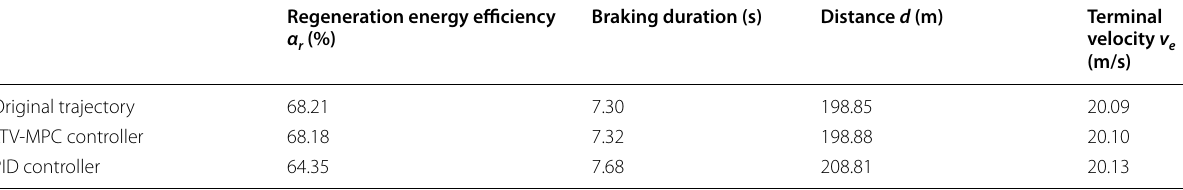
Table 2 Simulation result of LTV-MPC and PID